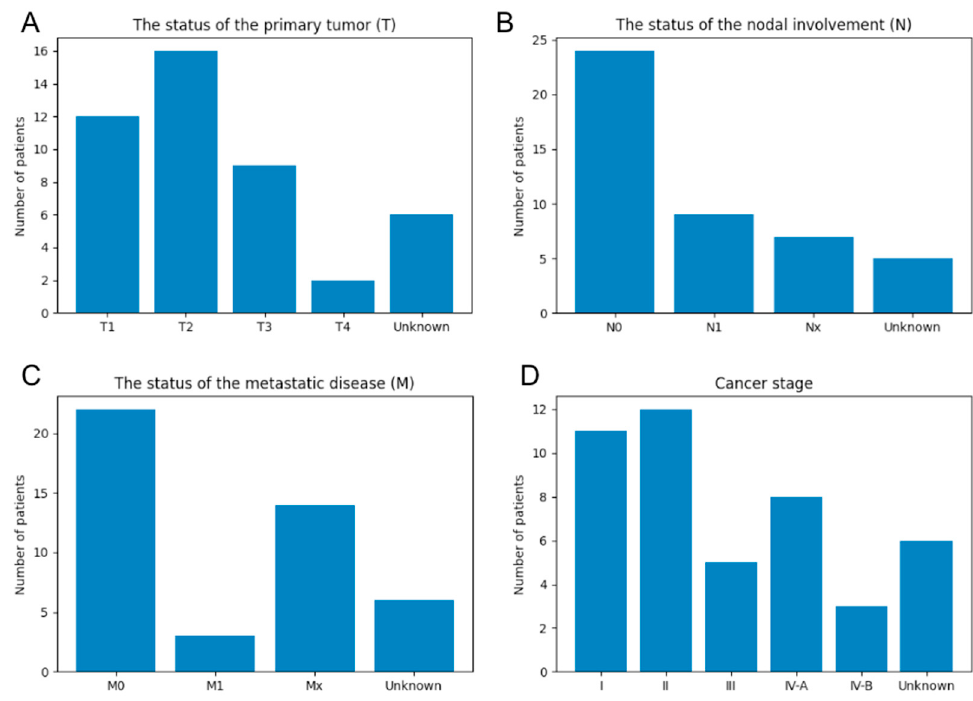
Figure 4. TNM classification ( A – C ) and cancer stage derived from the 7th edition of the UICC clas- sification ( D ) for human tissue microarray specimens.